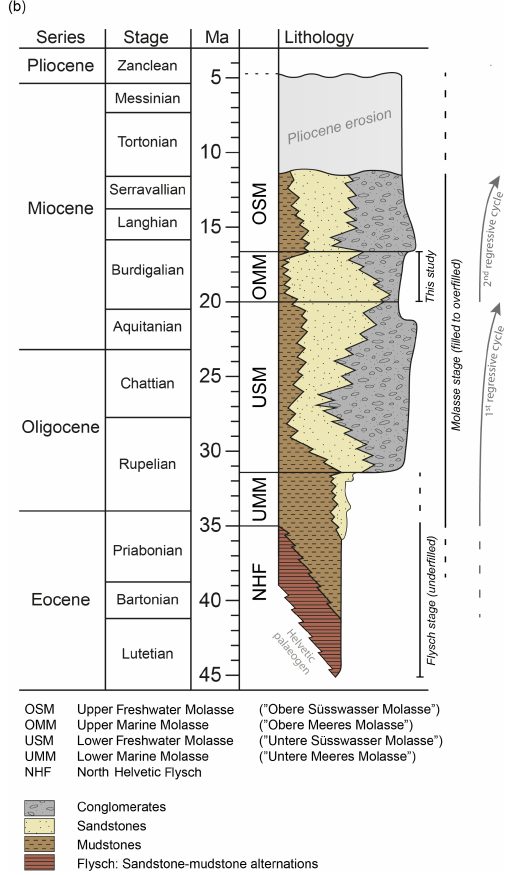
Figure 2. (a) Detailed geological map of the area between Geneva and Zurich adapted from Kissling and Schlunegger (2018) showing the locations of data points referred to in this paper. The OMM de- posits at sites 1 to 16 have been mapped at the scale of 1:25000, which was used to reproduce Fig. 6. In addition, the observations of the sections, outcrops, and drill core at sites 2, 4, 7, 9, 12, 13, and 16 are explicitly described in Sects. 4 and 5 of this paper. Please refer to Fig. 1 for the complete legend. (b) Lithostratigraphic scheme of the Molasse deposits in Switzerland. Modified after Keller